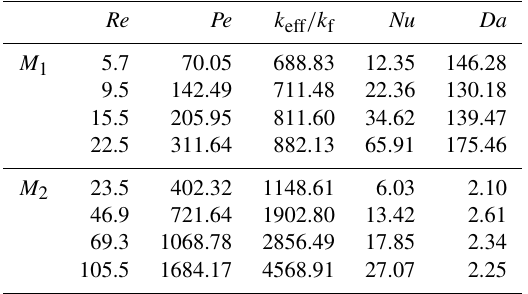
Table 3. Dimensionless numbers Pe , k eff /k f , Nu , and Da calculated for different Re values.